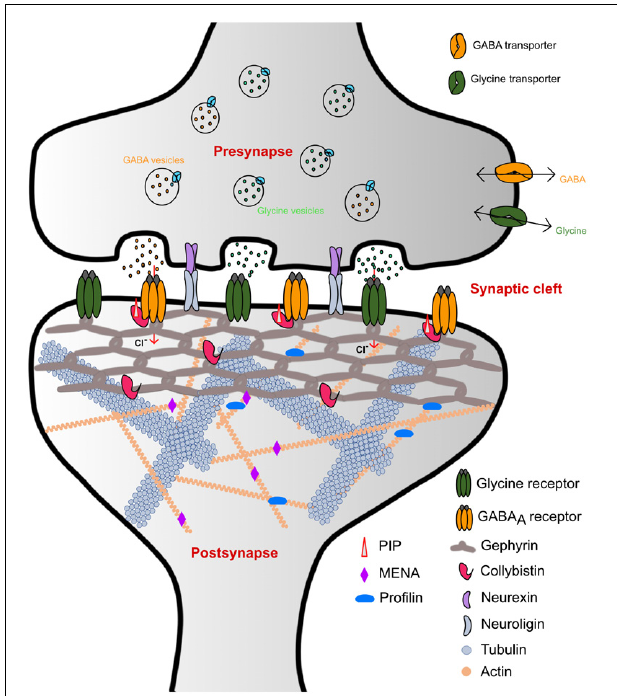
FIGURE 1 | Schematic representation of inhibitory synaptic specializations. While the simultaneous presence of both GlyRs and GABA A Rs was chosen for illustrative purposes, such a mixed receptor population exists in spinal cord neurons (Dumoulin et al., 2000). Please note that many interaction partners of gephyrin including DLC and Pin1 have been omitted from the schematic to improve